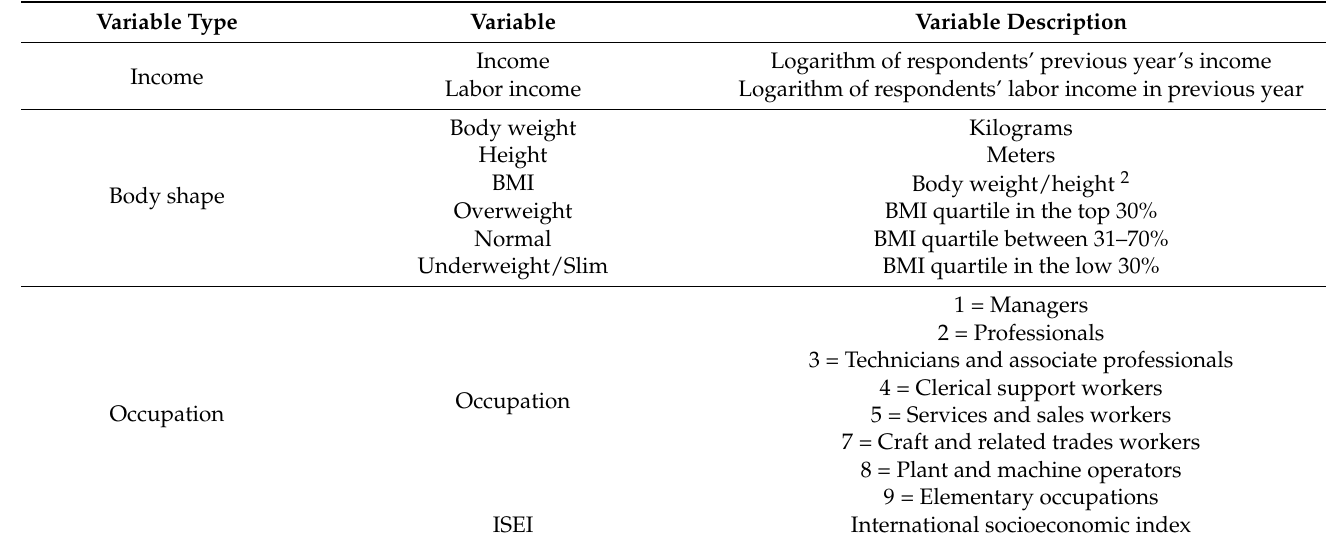
Table 1. Key variable